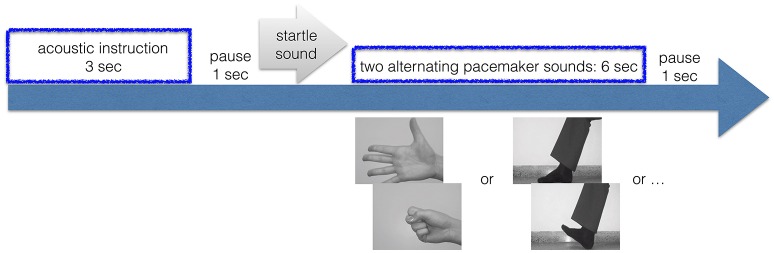
Trial. Time-line of one trial.